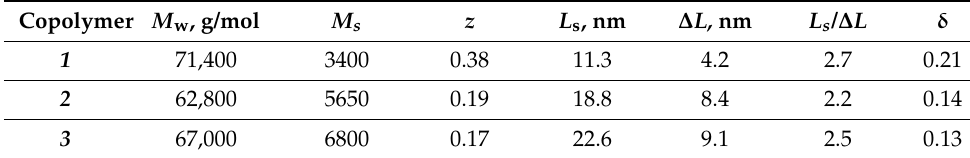
Table 2. Structural parameters for APE O -g-PiPrOx. Copolymer M w ,